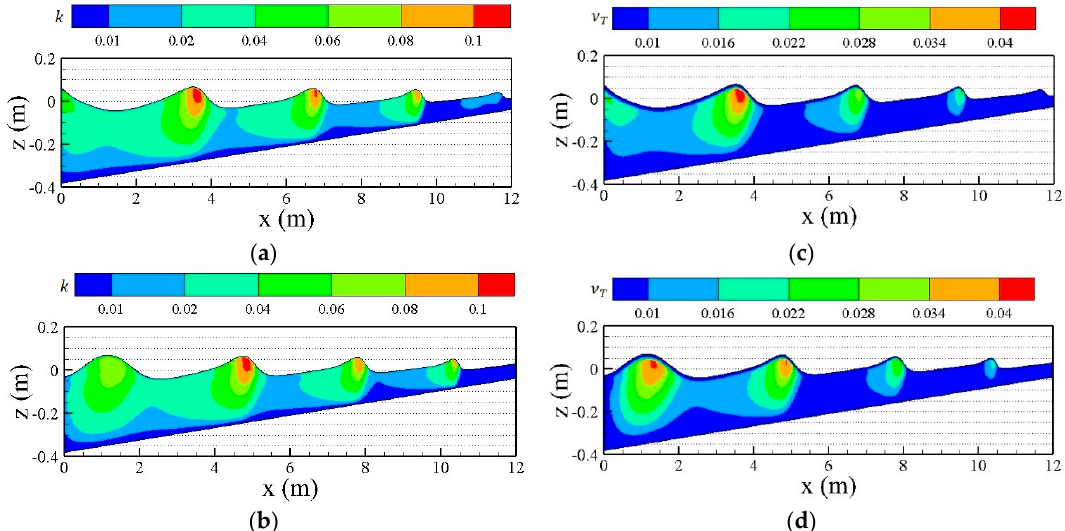
Figure 6. Ting and Kirby [21] spilling breaking wave test case. Instantaneous spatial distribution of the turbulent kinetic energy ( a,b ) and the turbulent eddy viscosity ( c,d ) in two different time steps, obtained by the Gallerano et al. [14] numerical model in which the turbulence model is the standard k − ε proposed by Rodi [23].